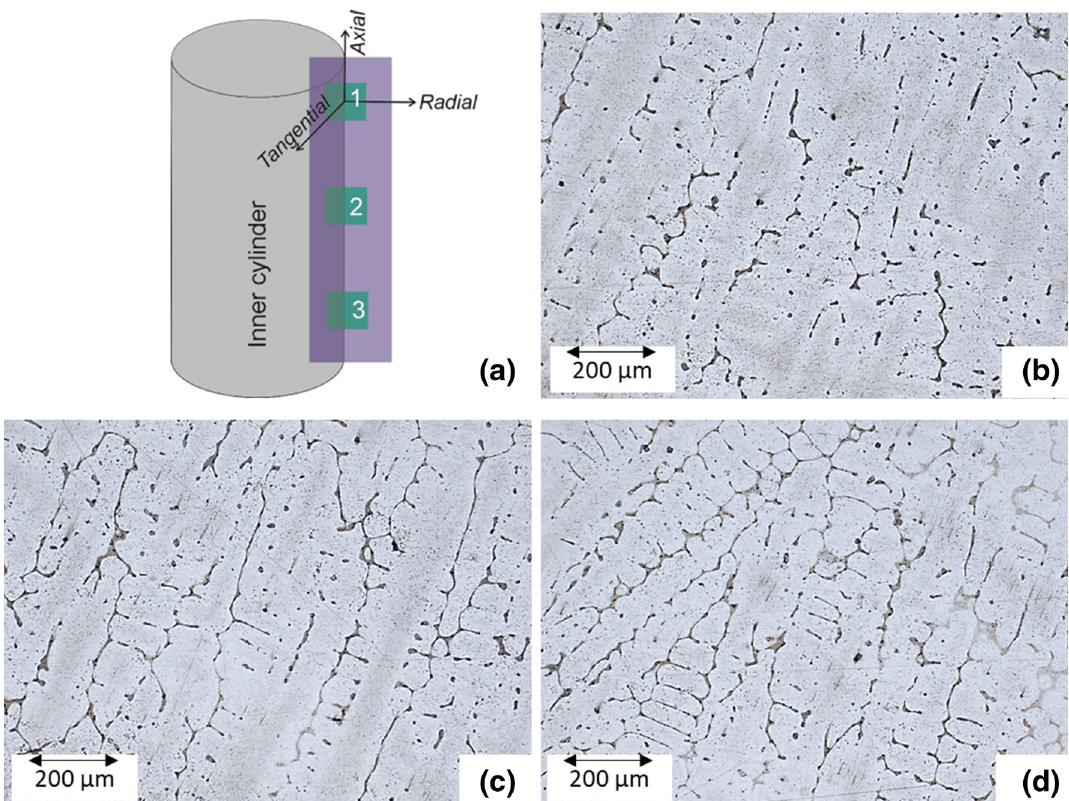
(c) shows the sample near the half height of the cylinder, and (d) shows the micrograph near the bottom of the cylinder. All micro- graphs are oriented with the normal to the image plane pointing in the tangential direction